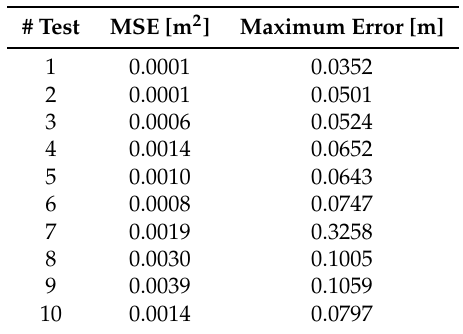
Table 4. Error results for the simulated forward tests.